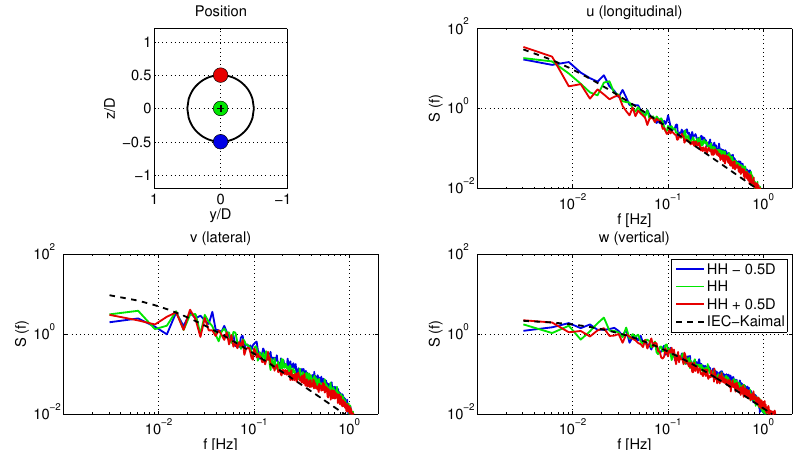
Figure 4. Power spectra for the three free-stream turbulence components at different heights.